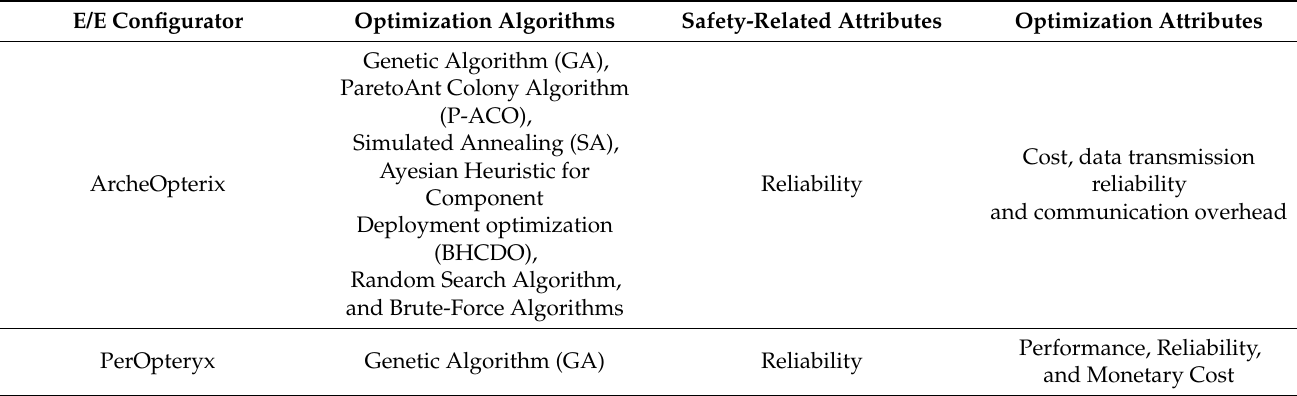
Table 2. The used optimization algorithms, and the covered optimization and safety-relevant at- tributes in the above-explained open-source